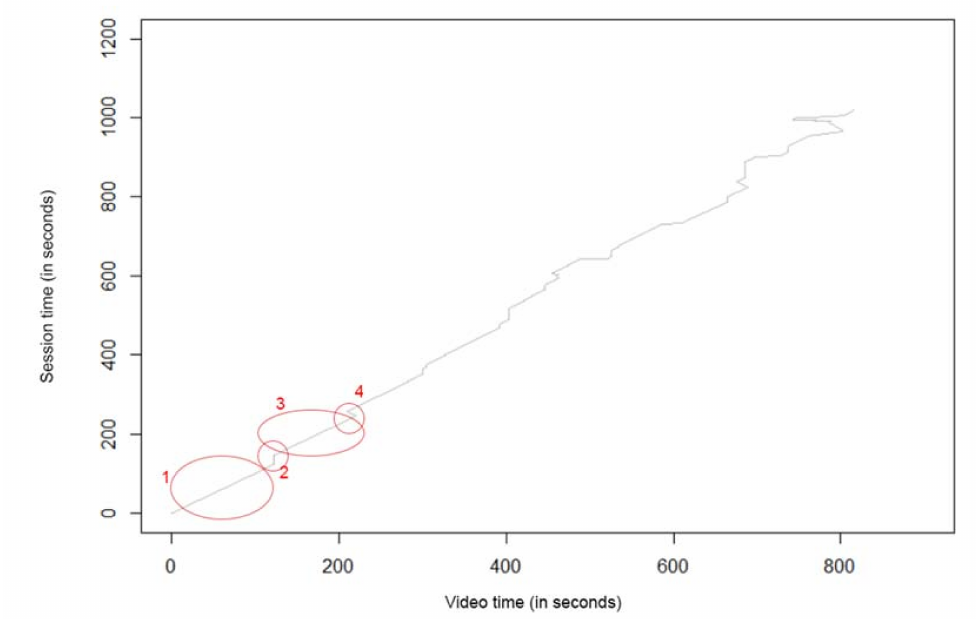
Figure 2. Single playback visualization for a typical session. The video is 810 s long (13 (cid:48) 30 (cid:48)(cid:48) ), and the playback session lasts 1013 s (16 (cid:48) 53 (cid:48)(cid:48) ). The presented session corresponds to a student watching